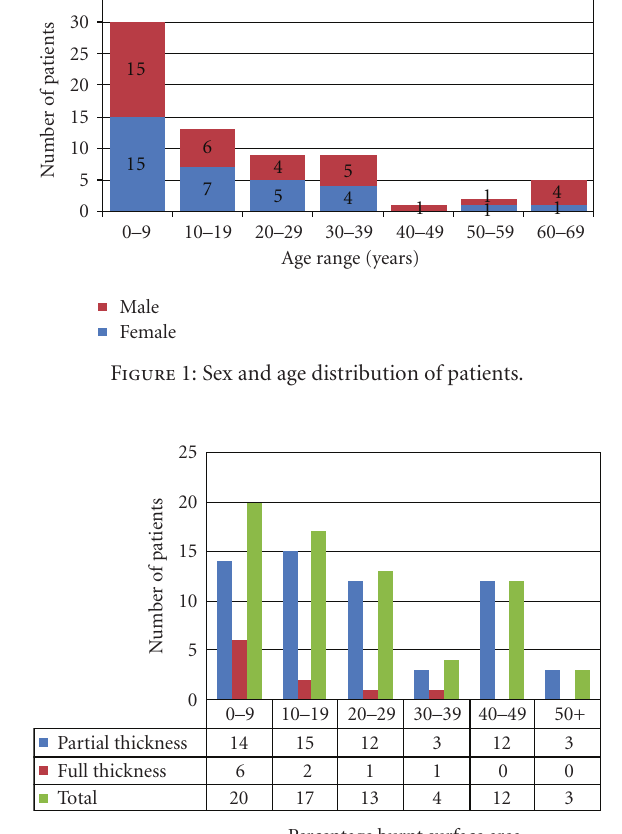
Figure 2: Frequency of total burnt surface area and depth of burn.